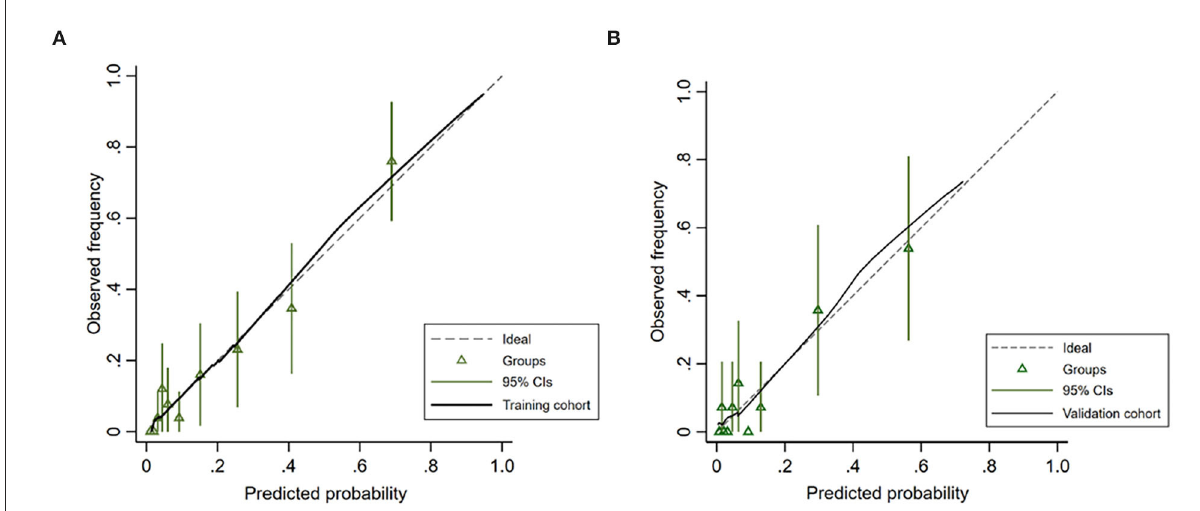
FIGURE4 Calibration plot for predicting HT after intravenous thrombolysis in the training cohort (A) and the validation cohort (B) .